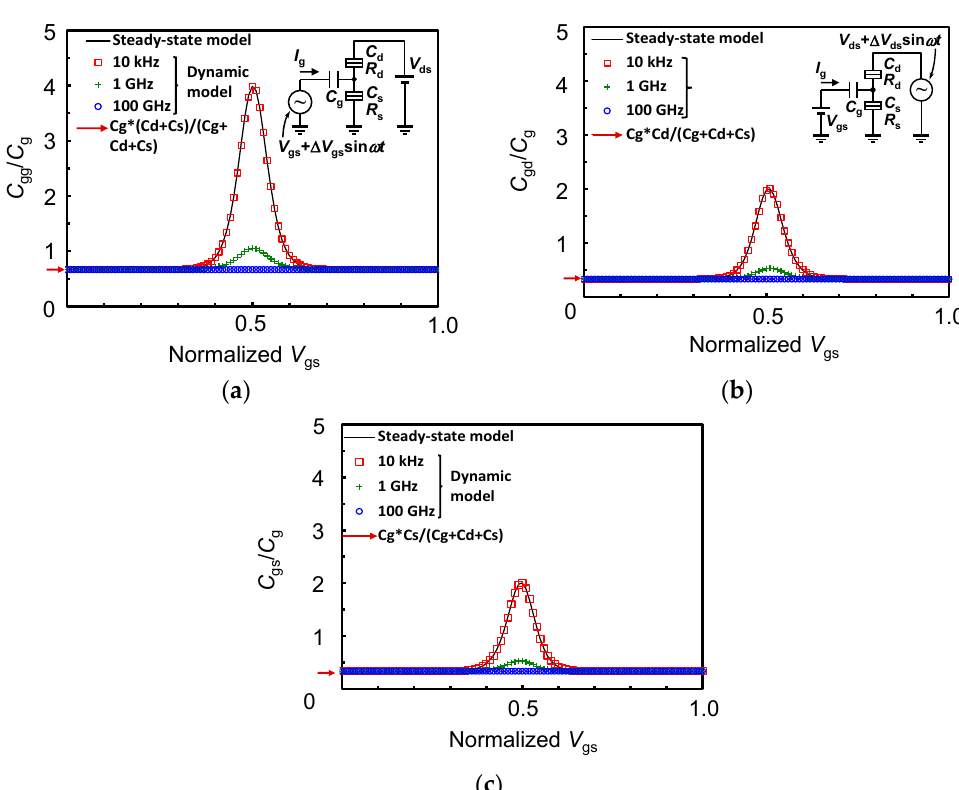
Figure 3. ( a ) SET input capacitance C gg ( b ) drain-to-gate capacitance C gd and ( c ) source-to-gate capacitance C gs as a function of gate voltage V gs for a low drain voltage V ds = 0.534 mV [0.01] at T = 15.5 K [0.05].